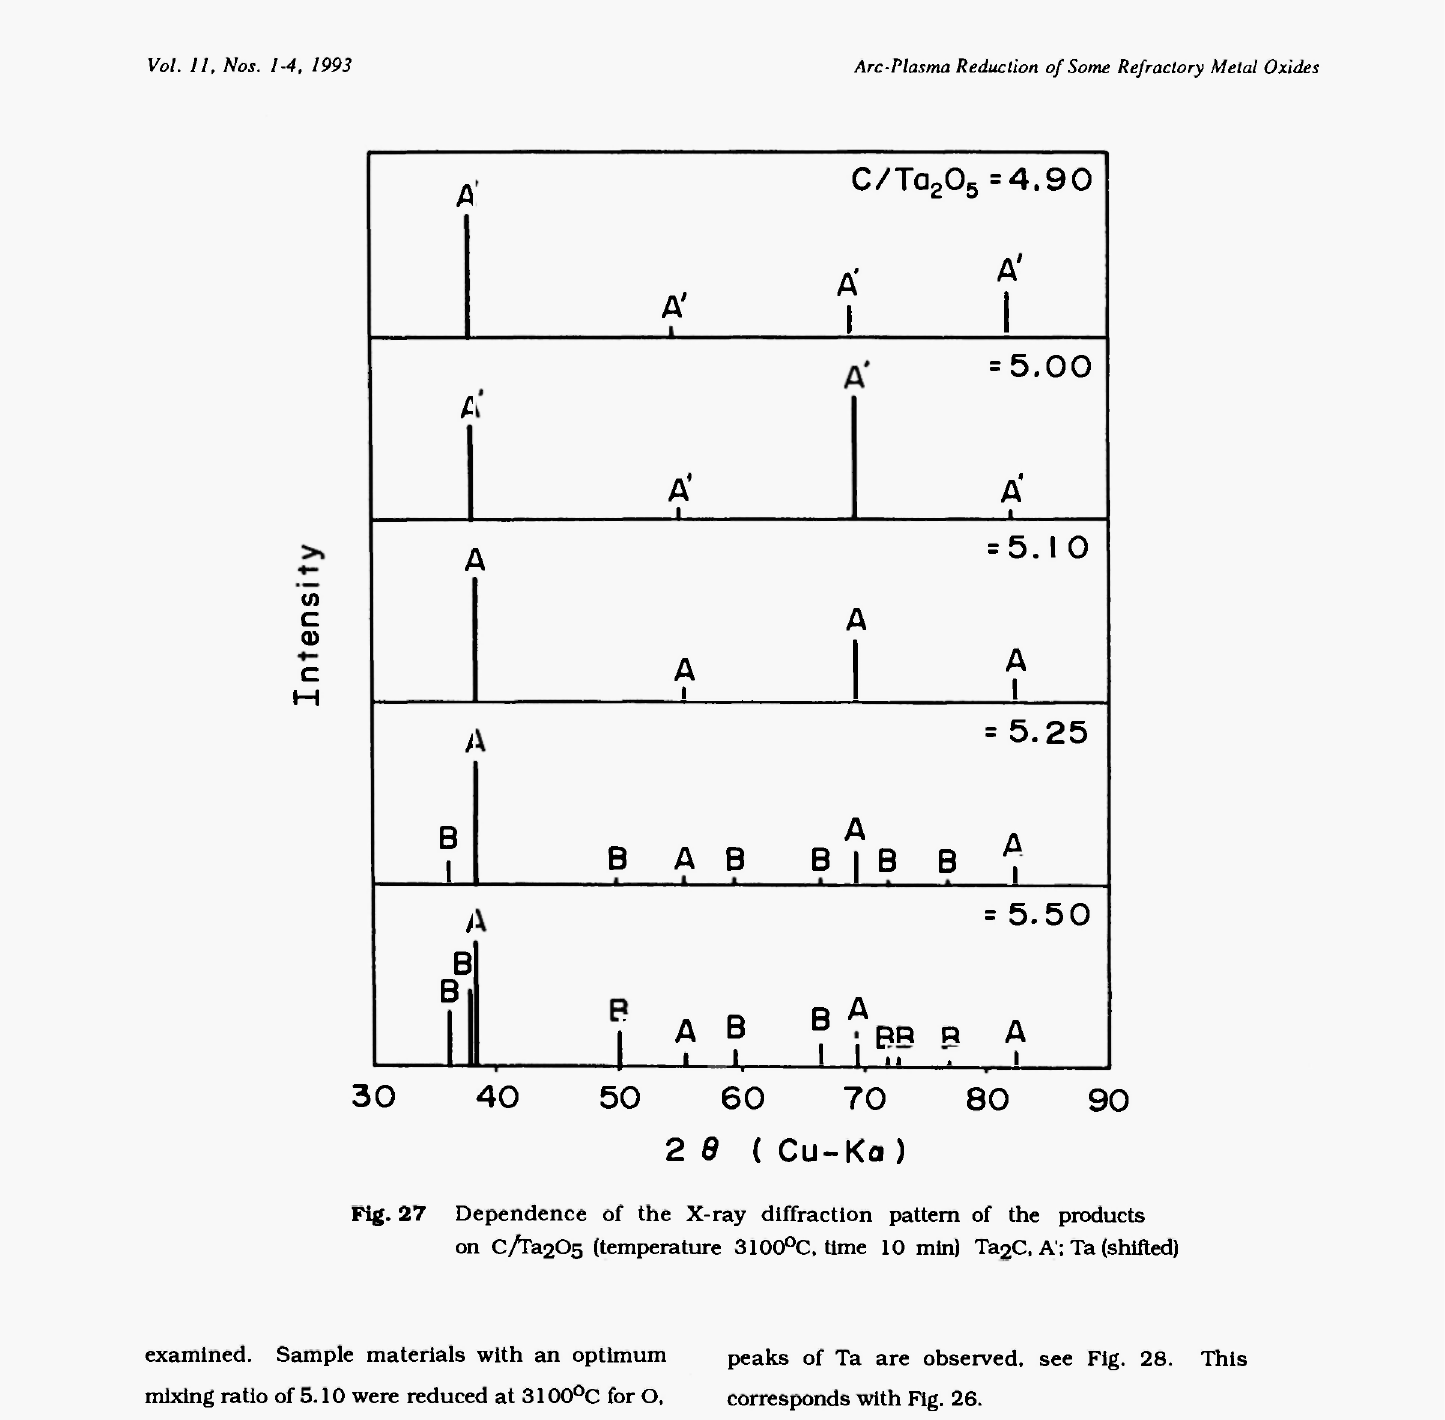
Fig. 27 Dependence of the X-ray diffraction pattern of the products on C/Ta205 (temperature 3100°C, time 10 min) Ta2C. A'; Ta